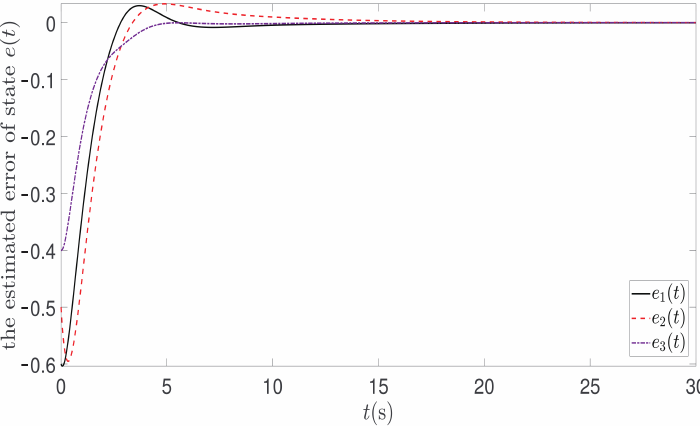
Figure 14. The estimated error curves of the states.